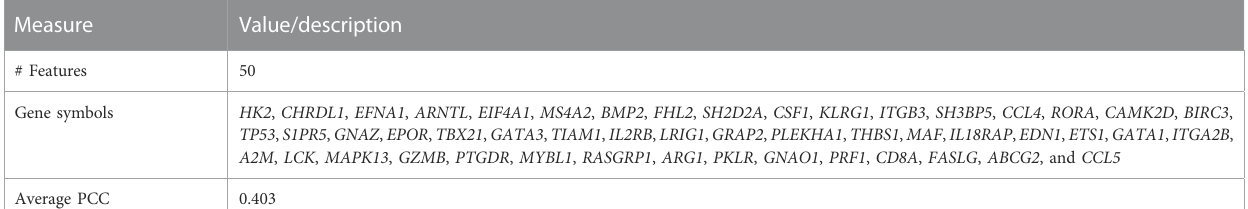
TABLE 3 Feature (gene) names and average (avg.) Pearson ’ s correlation coef fi cient (PCC) for the pairwise manner within the TCGA LAML signature.